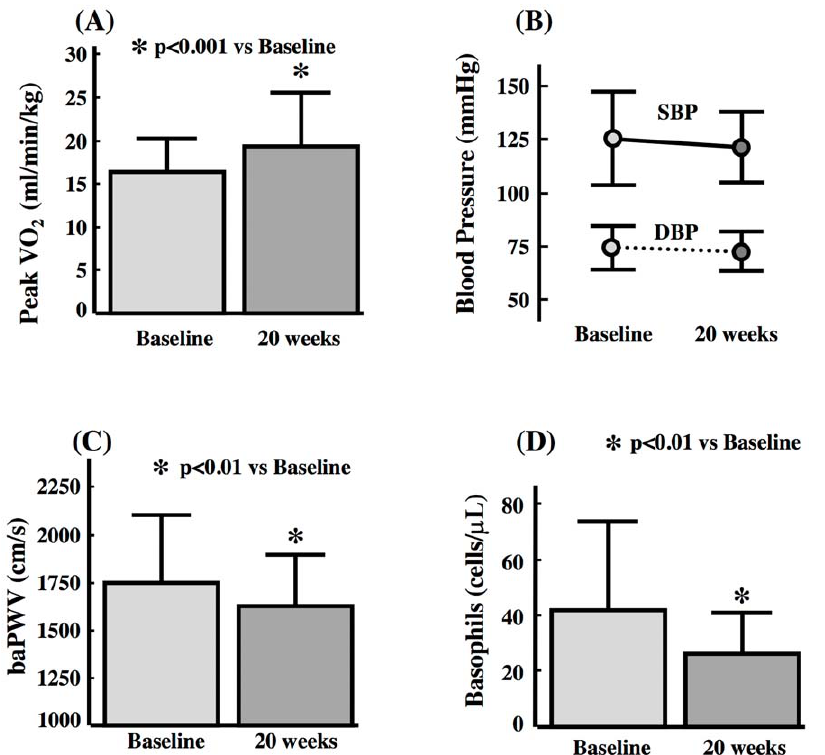
Figure 1. Effect of Combination Treatment on Arterial Wall Stiffness and Plasma Basophil. Effects of treatment on (A) peak oxygen uptake (peak VO 2 ), (B) blood pressure, (C) arterial wall stiffness measured by brachial and ankle pulse wave velocity (baPWV) and (D) plasma basophil count using data of all patients (n=28). Data are mean 6 SD. SBP, systolic blood pressure; DBP, diastolic blood pressure.